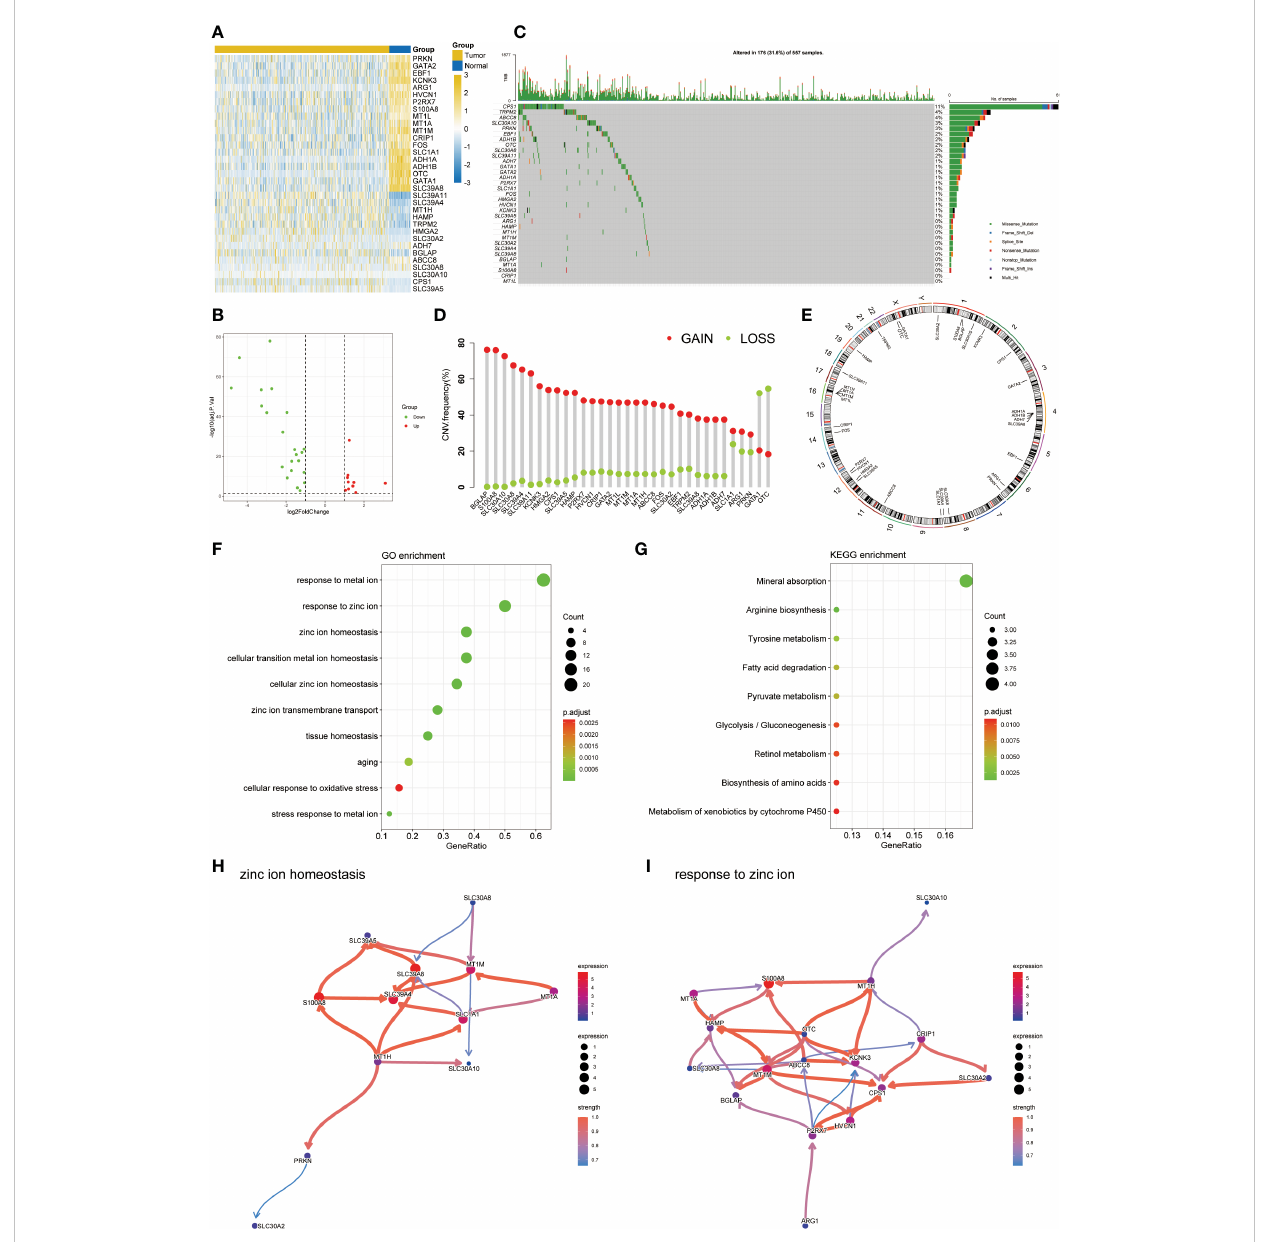
FIGURE 2 Characteristic of zinc metabolism-related genes in LUAD. (A) Heatmap showing the differences of zinc metabolism-related genes in LUAD and normal samples. (B) Volcano plot exhibiting 22 down-regulated and 11 up-regulated genes. (C) Gene mutation landscape of LUAD in TCGA. (D) The CNV mutation frequency of 33 zinc metabolism-related genes. (E) Chromosome position and alteration of zinc metabolism-related genes. (F) GO enrichment analysis. (G) KEGG enrichment analysis. Gene interaction network diagram in zinc ion homeostasis (H) and response to zinc ion (I)